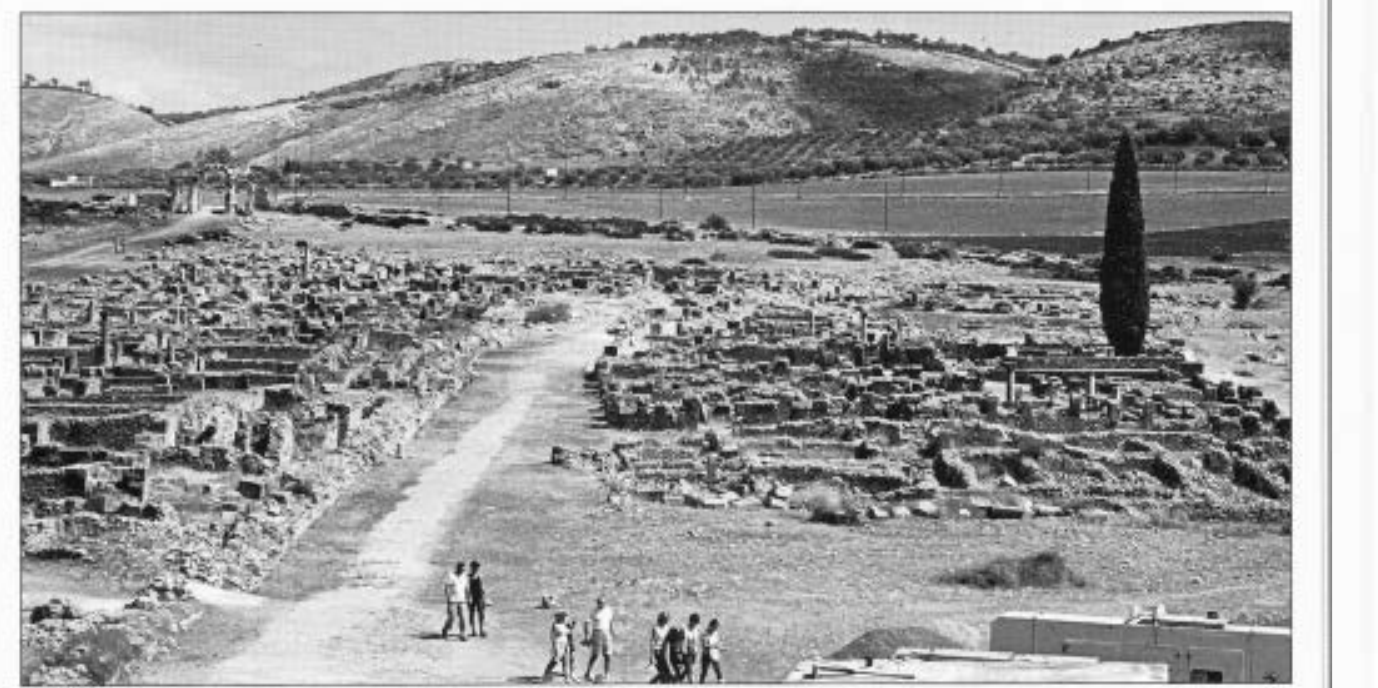
Figure 2 Vi ew of the northeast quarter of the Roman city of Volubilis from the centre of the ancient